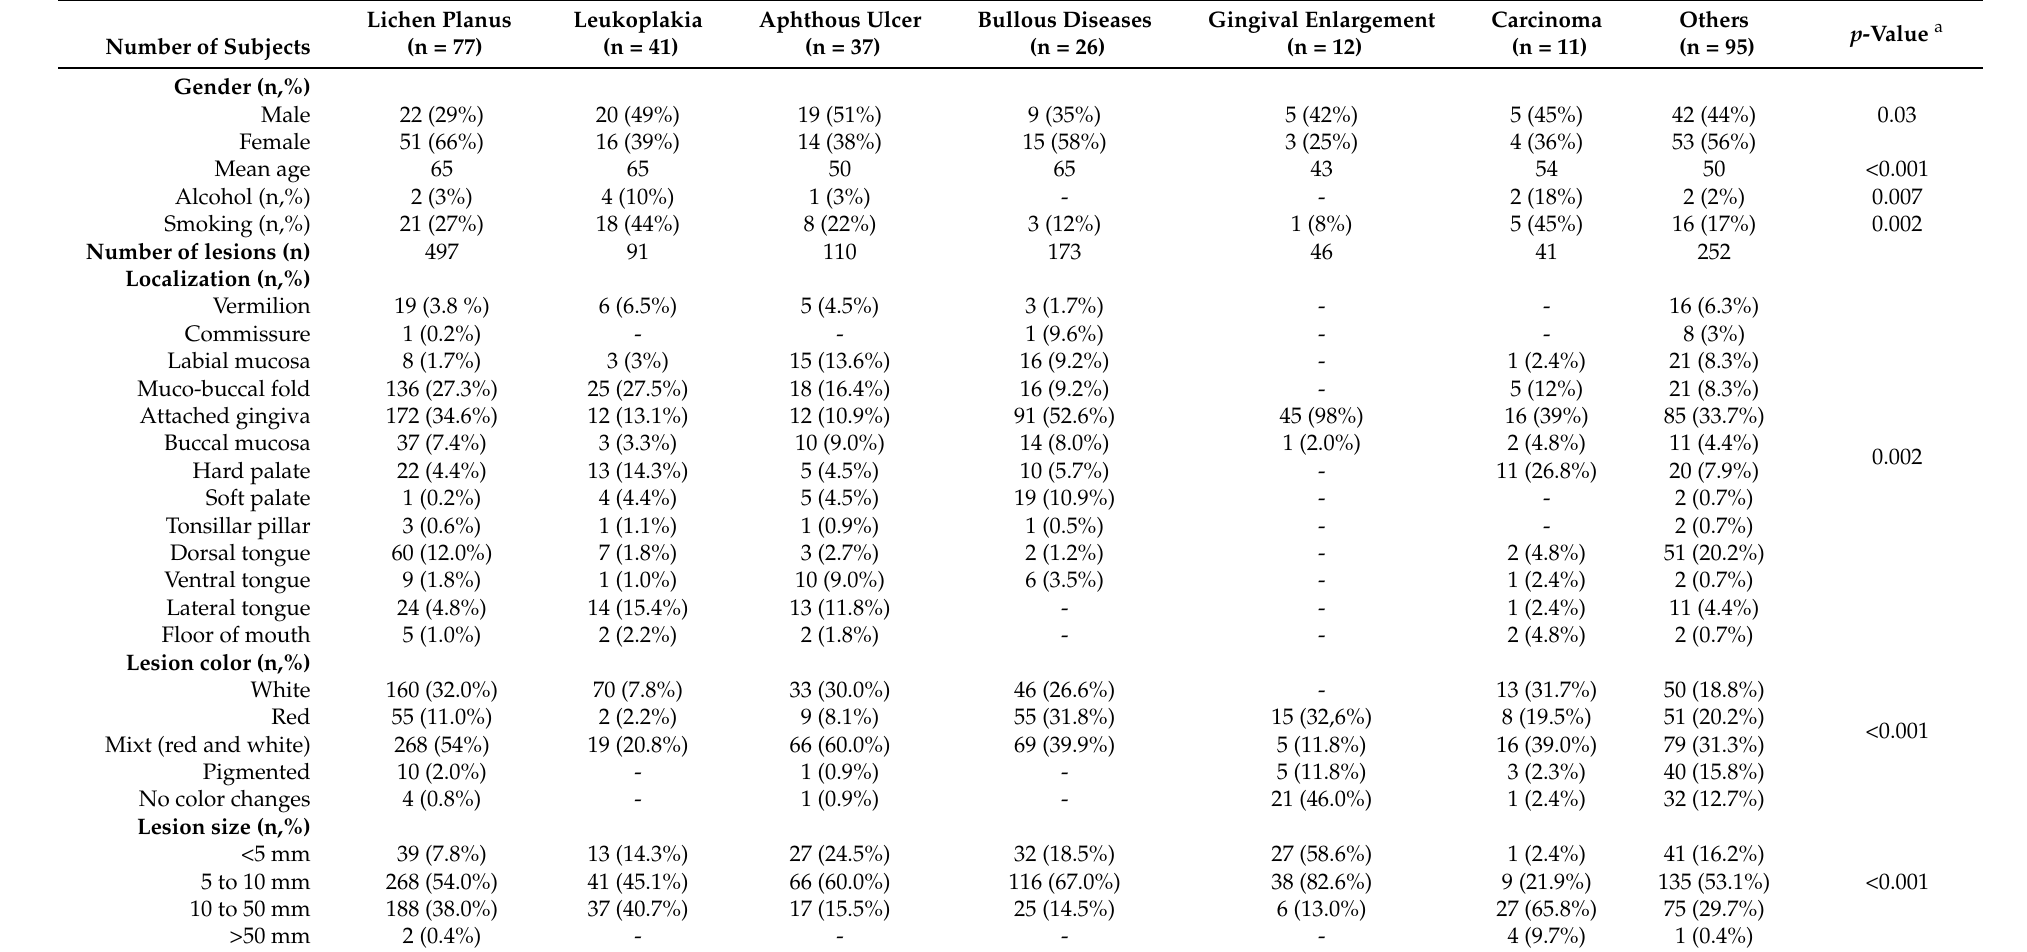
Table 1. Subject characteristics are used for machine learning model training according to each diagnosis. Lichen Planus Leukoplakia Aphthous Ulcer Bullous Diseases Gingival Enlargement